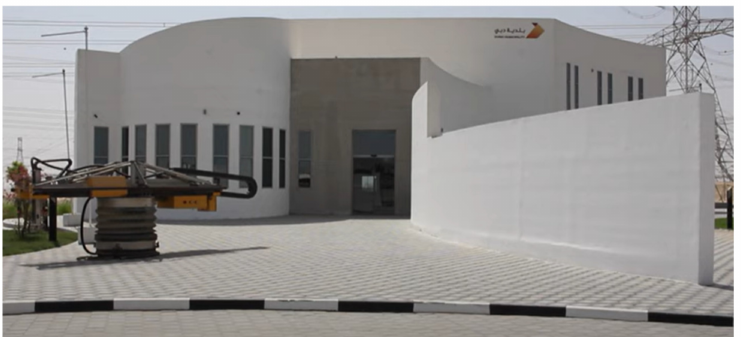
Figure 16. Apis Cor completed building in Dubai [40]. Reprinted with permission from Ref. [40]. 2021, Jarett Gross.